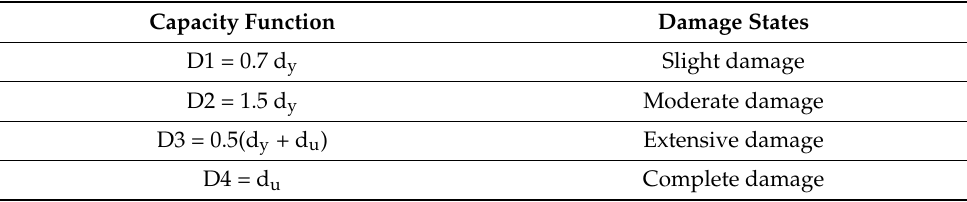
Table 5. Capacity functions of various damage states for fragility analysis